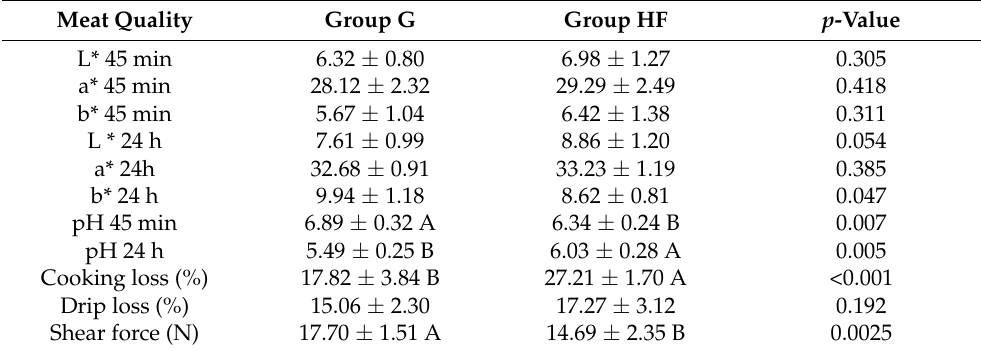
Table 3. Effects of fattening on meat quality in LD muscle of